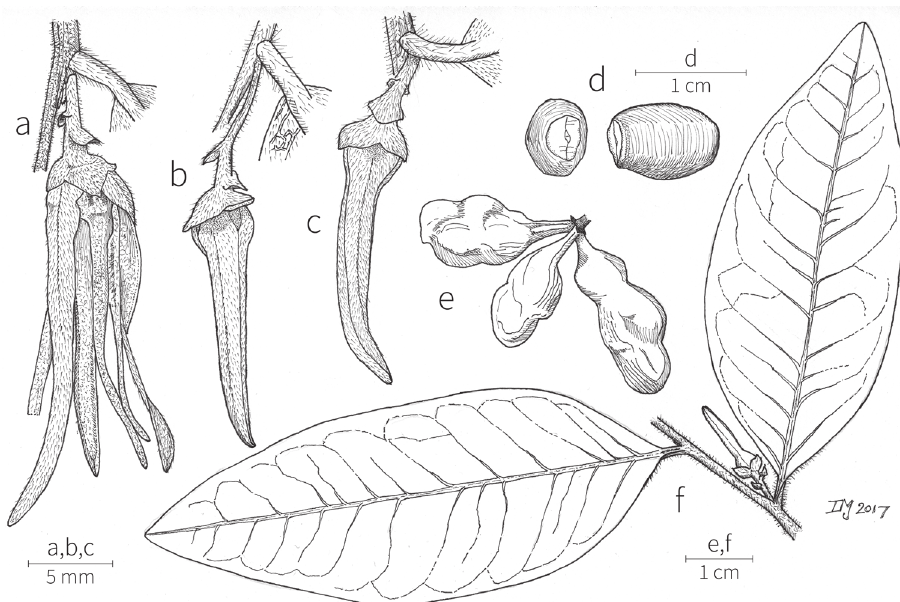
Figure 40. Xylopia elliotii. A Flower, side view, of specimen from Guinea B Flower bud, side view, of specimen from Central African Republic C Flower bud, side view, of isolectotype specimen from Sierra Leone D Seed, view of micropylar end and side view E Fruit F Habit. A from Adam 11846 (MO) B from Le Testu 3787 (P) C from Scott-Elliot 5325 (GH) D from Pobéguin 1529 (P) E from Scott-Elliot 5328 (GH) F from Scott-Elliot 5288